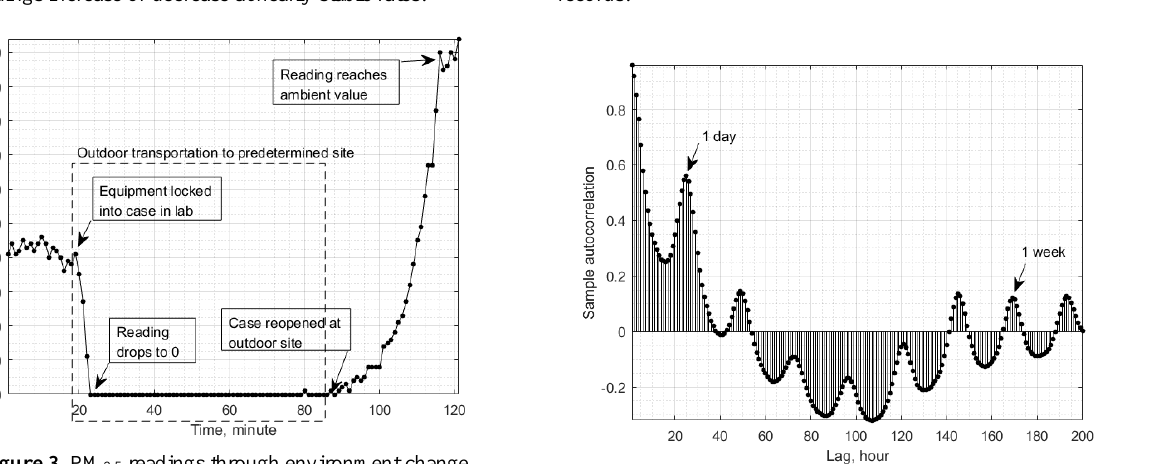
Figure 3 . PM 2.5 readings through environment change